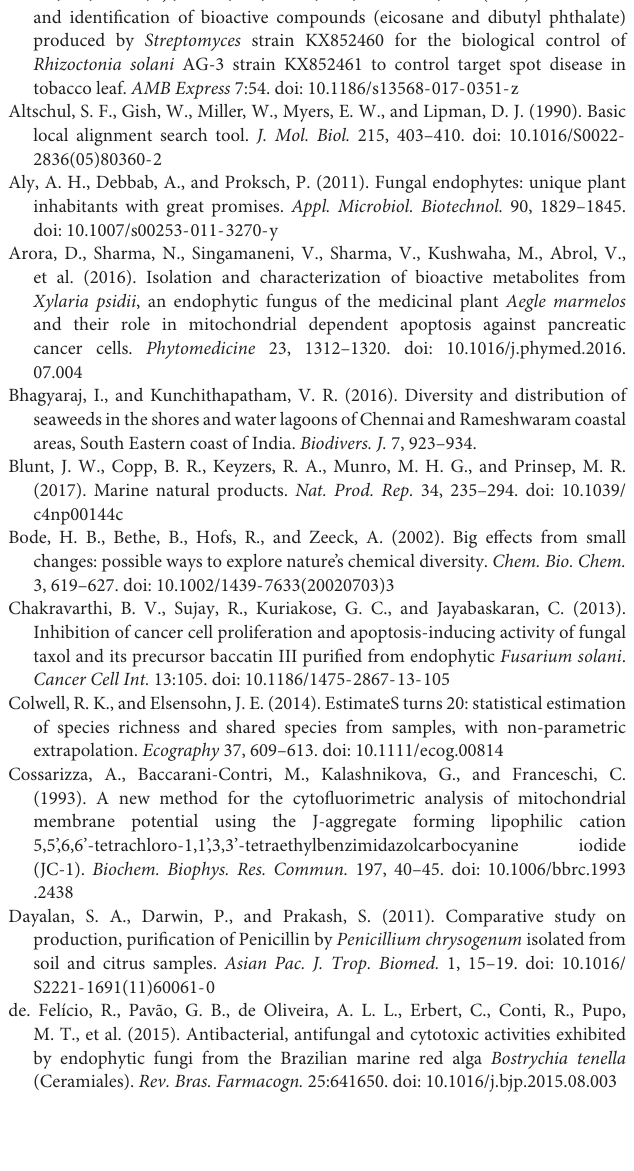
Debbab, A., Aly, A. H., and Proksch, P. (2011). Bioactive secondary metabolites from endophytes and associated marine derived fungi. Fungal Divers. 49,